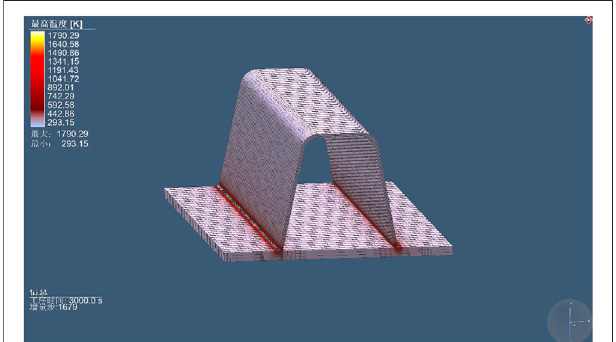
FIGURE 4 | Model of temperature fi eld.